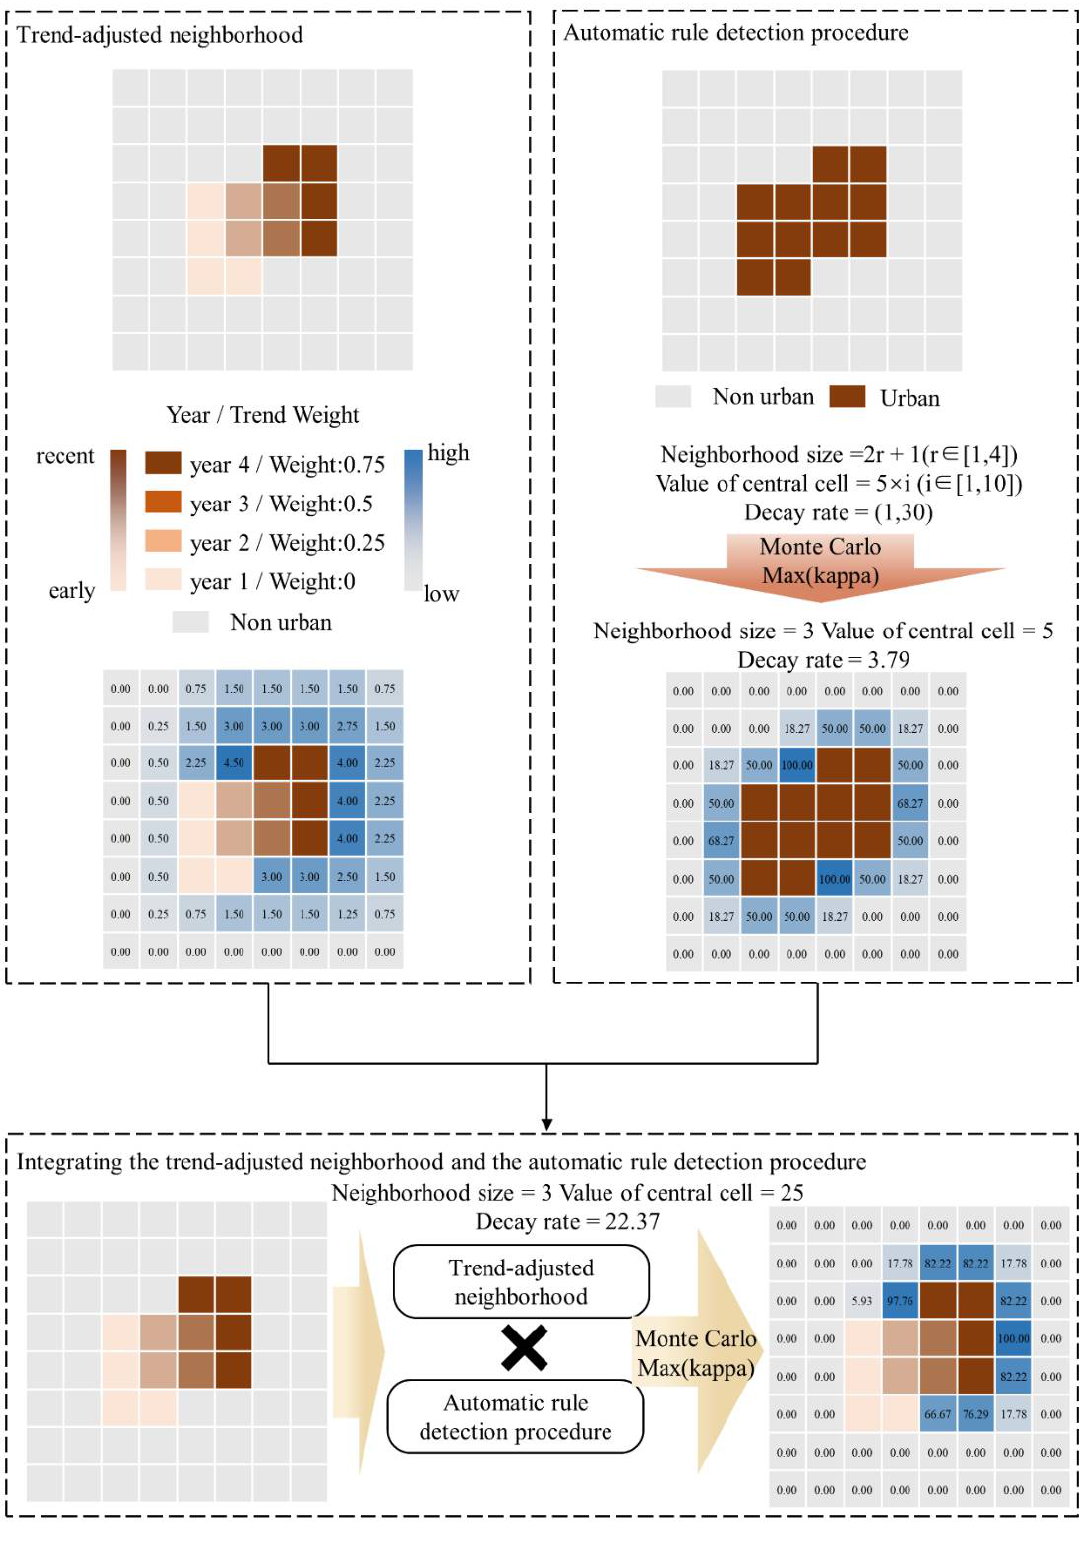
Figure 2. Illustration of the neighborhood calculation.